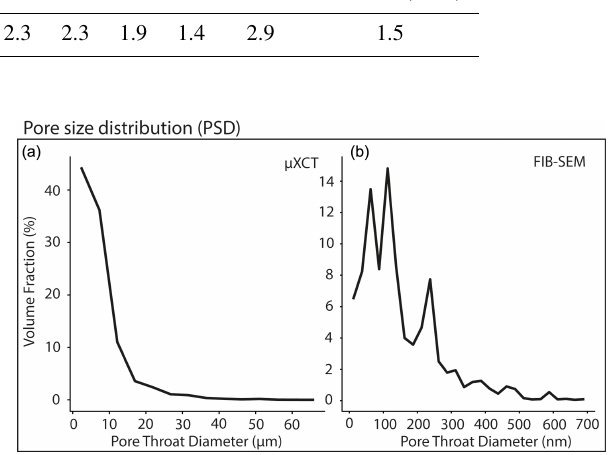
Figure 9. Pore throat diameters from µXCT (a) and FIB-SEM im- ages (b)